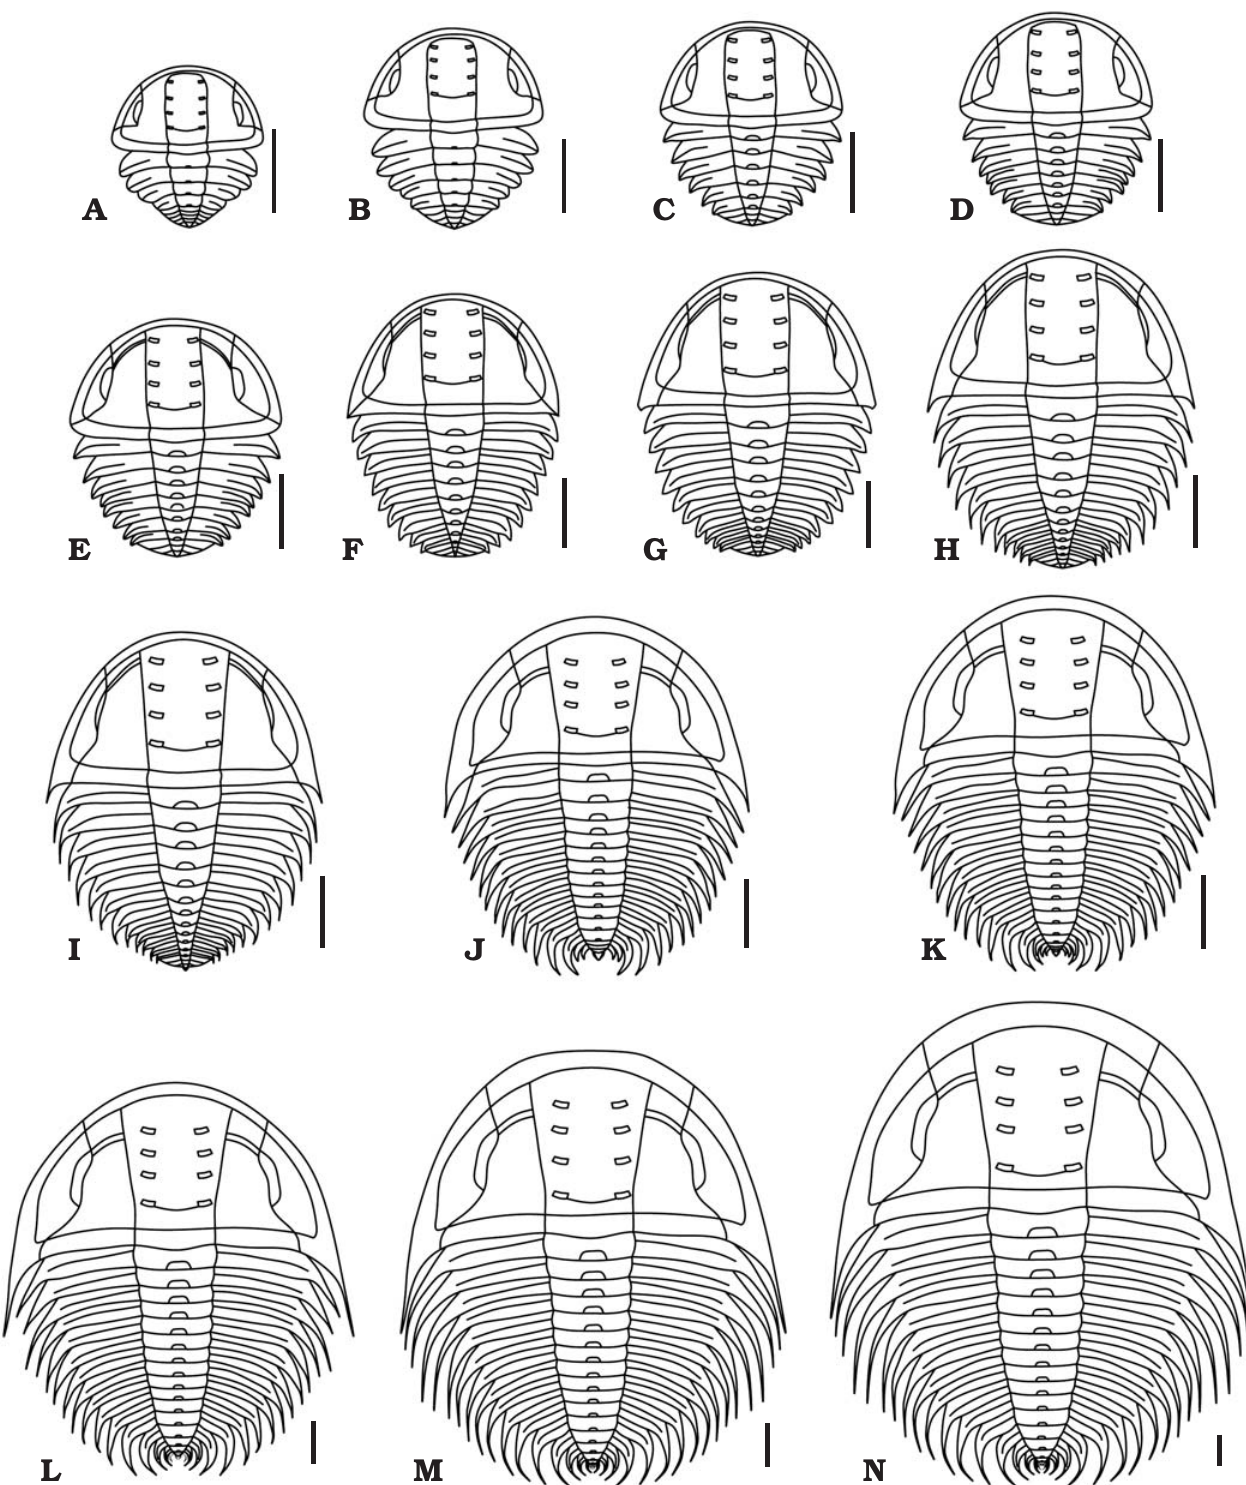
Fig. 7. Reconstructions in dorsal view of ontogenetic series of Changaspis elongata Lee in Chien, 1961. A – M . D4–16. N . H. Scale bars 1 mm. Fig. 6. Meraspid and holaspid exoskeletons of oryctocephalid trilobite Changaspis elongata Lee in Chien, 1961 from the Balang Formation (Cambrian Stage 4), Jianhe County, Guizhou Province, South China. A . D16, JLZ-160-1214; close-up of the last 11 thoracic segments and pygidium (A 2 ). B . H, JLZ- 160-296; close-up of the last 11 thoracic segments and pygidium (B 2 ). C . H, JLZ-175-158; close-up of the last 12 thoracic segments and pygidium (C 2 ). D . H, JLZ-160-2796; close-up of the last 12 thoracic segments and pygidium (D 2 ). The arrows represent the position of the thoracic-pygidial boundary. Abbreviations: PY, pygidium; TS6–17, thoracic segments 6–17. Scale bars 1